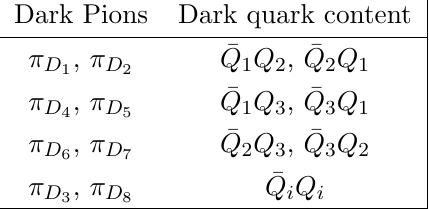
Table 1. Dark quark content of the dark